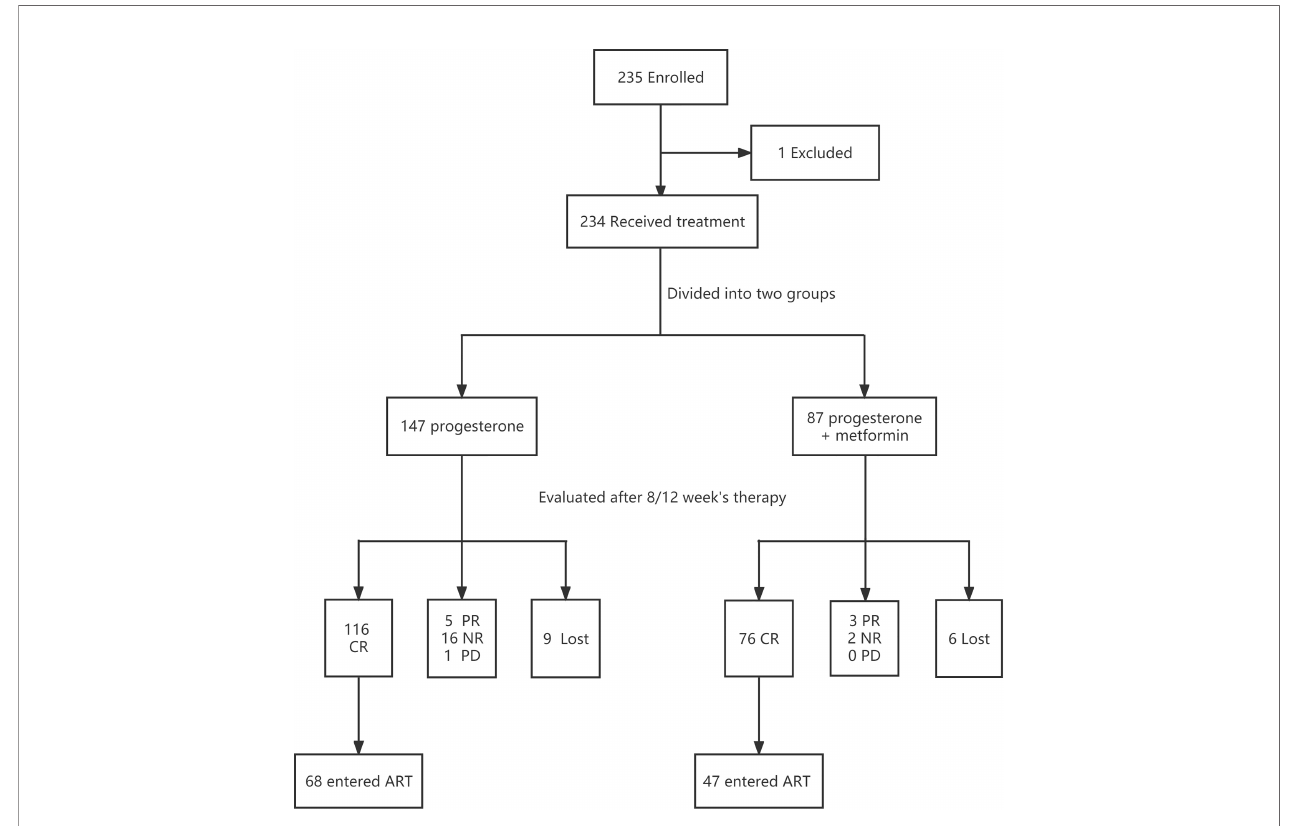
FIGURE 1 | Study fl ow